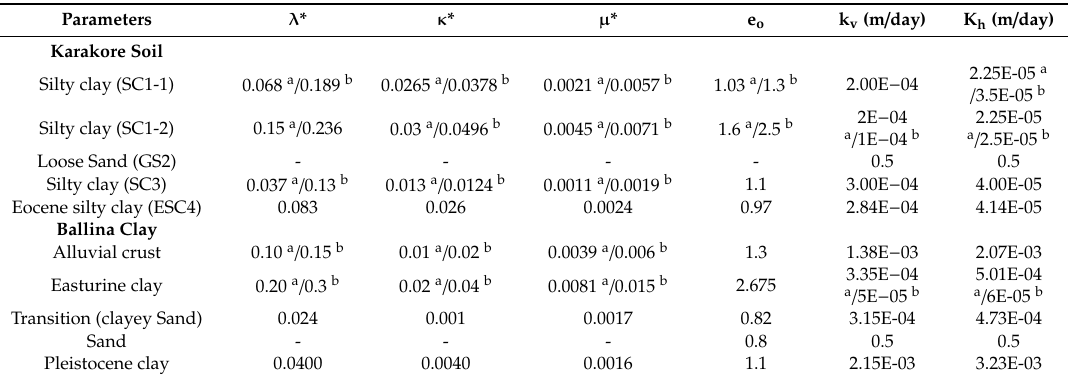
Table 3. SSC model mean soil parameters for Class A and Class C